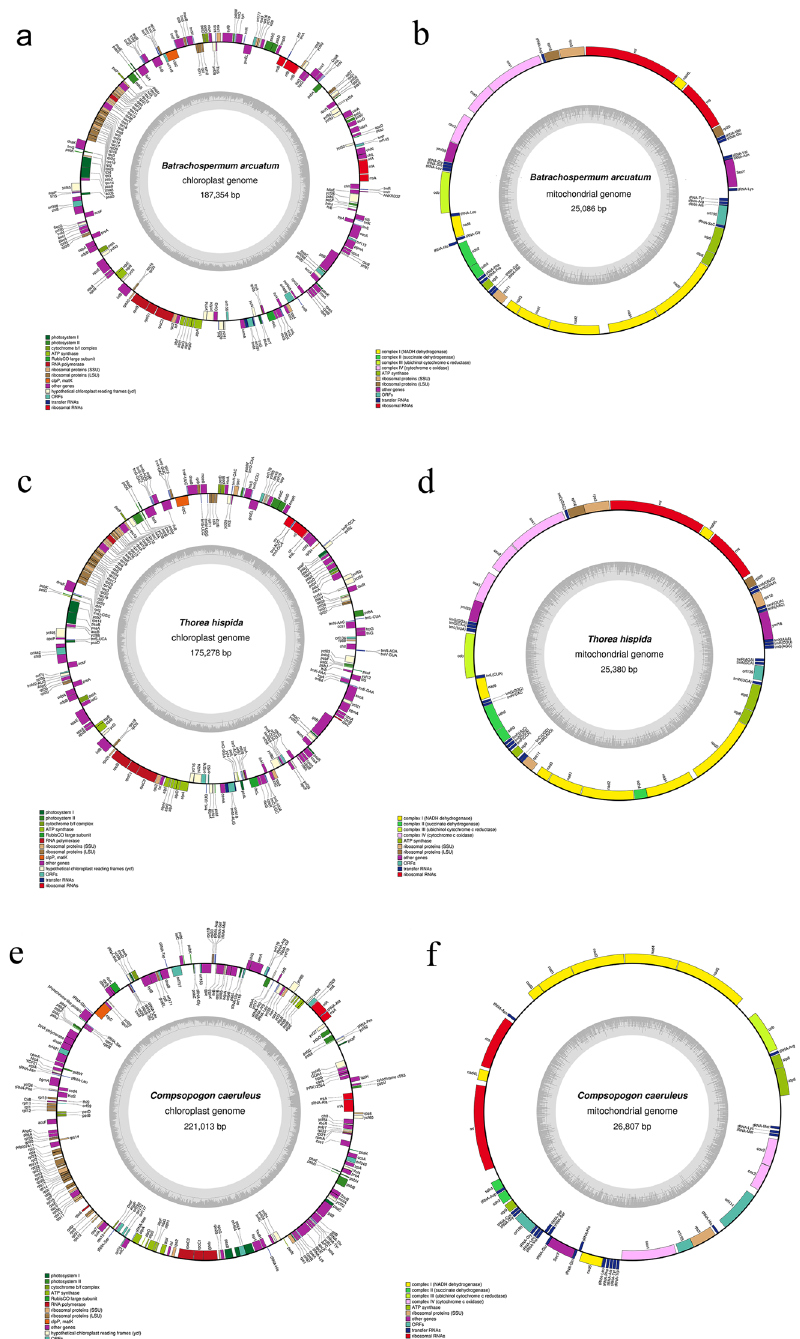
Figure 1. Organelle genome maps of freshwater Rhodophyta representatives. The genes inside and outside of the circles are transcribed in the clockwise and counterclockwise directions, respectively. Genes belonging to different functional groups are shown in different colors. ( a ) Chloroplast genome map of Batrachospermum arcuatum . ( b ) Mitochondrial genome map of Batrachospermum arcuatum . ( c ) Chloroplast genome map of Thorea hispida . ( d ) Mitochondrial genome map of Thorea hispida . ( e ) Chloroplast genome map of Compsopogon caeruleus . ( f ) Mitochondrial genome map of Compsopogon caeruleus